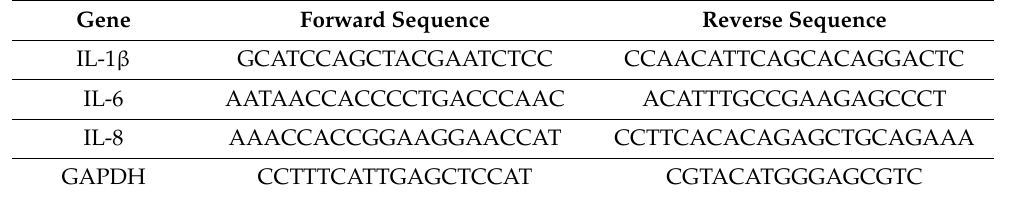
Table 3. Primers for the inflammation